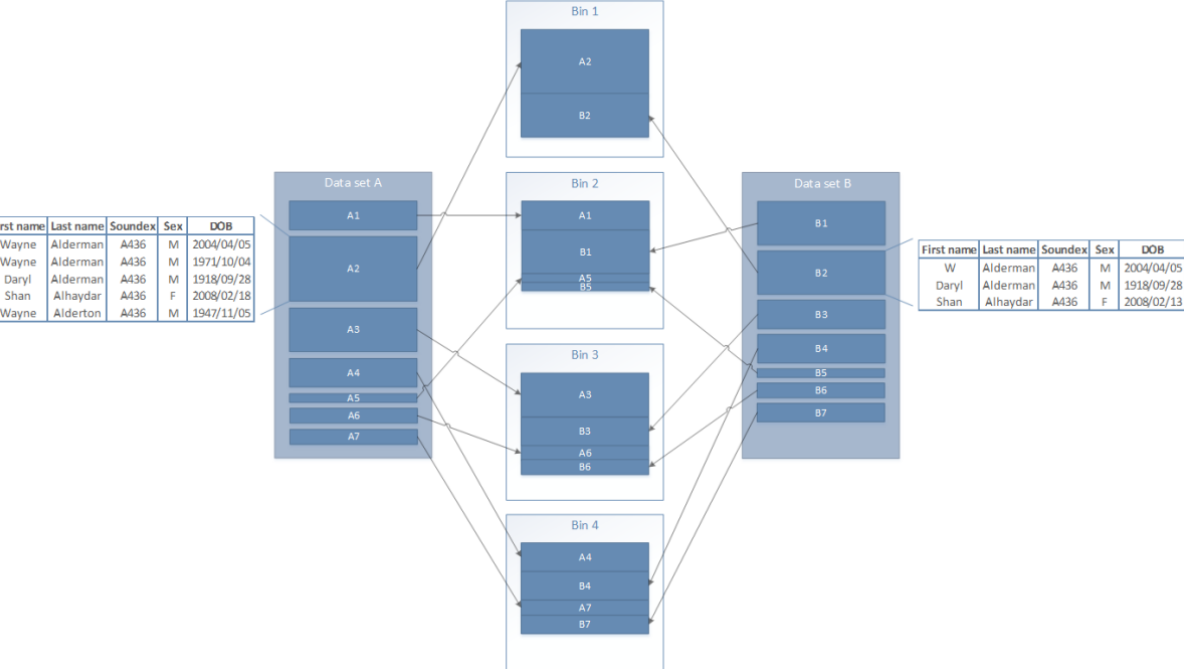
Figure 8. Datafiles split into independent bins (by Soundex block values) for matching. DOB: date of